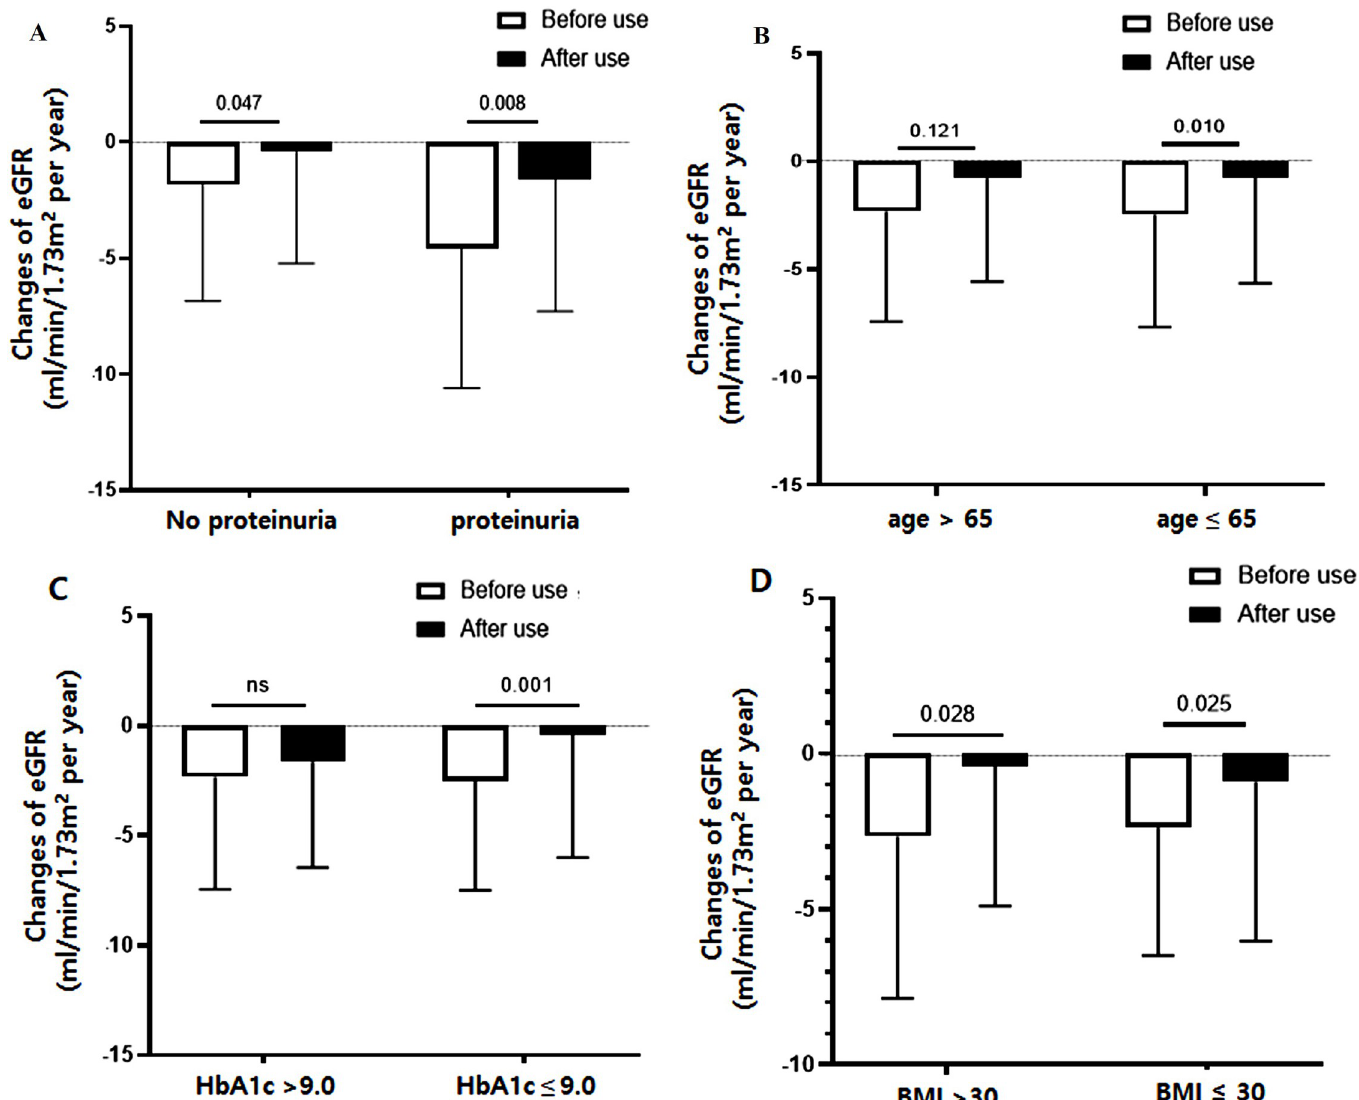
Fig 3. Clinical factors affecting renal response to dulaglutide. (A) A significantly less decline in eGFR was observed in participants with baseline proteinuria compared with those without. (B, C) The effect of dulaglutide use on eGFR changes was better in relatively young patients (age � 65 years) and in those with HbA1c � 9.0%. (D) However, changes in the eGFR were not associated with the baseline